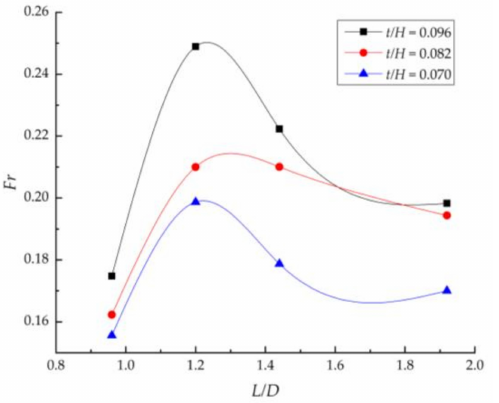
Figure 8. Critical Fr of ice of di ff erent sizes for the same t / H